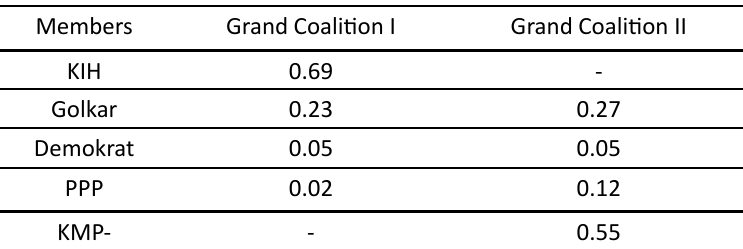
Table 5: Shapley value with coalitional